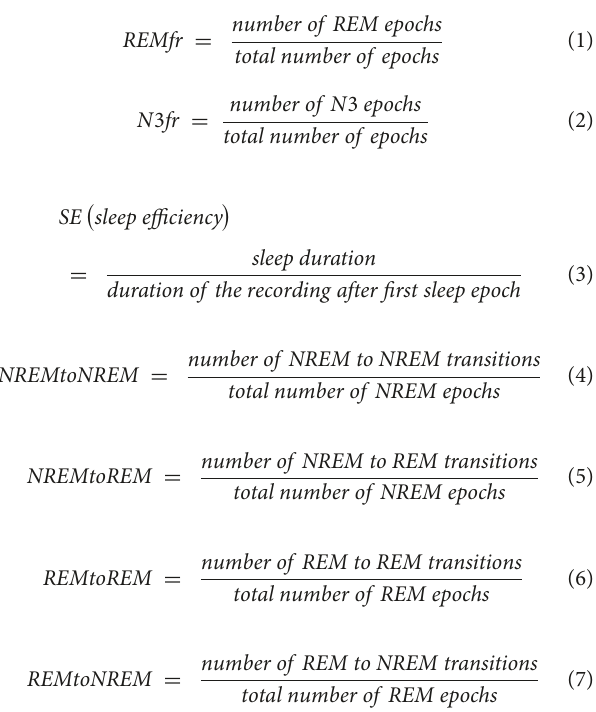
[ER1, ER2, and Avg(ER1,ER2)] referenced to the channels from